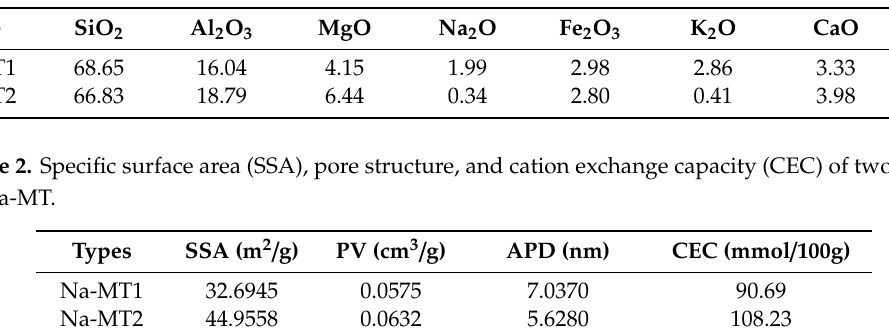
Table 1. Chemical composition of two kinds of Ca-MT (wt %). MT = montmorillonite.